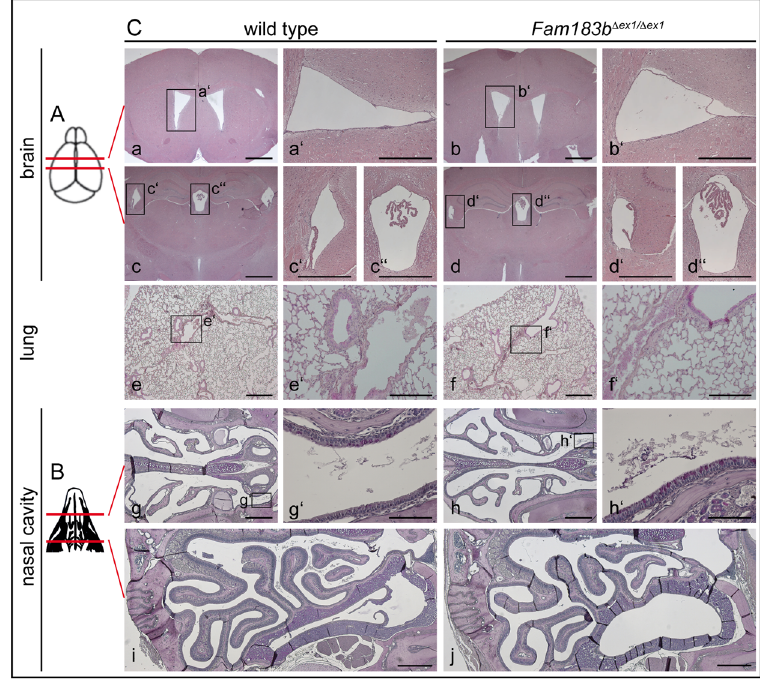
Figure 5. Histological analysis of Fam183b -mutant tissues. ( A ) Schematic drawing showing the planes of sections shown in ( C a–d). ( B ) Scheme depicting planes of sections shown in ( C g–j). ( C a–d) Representative sections of wild type (a,c) and Fam183b Δ ex1 mutant brains (b,d) at the two horizontal levels indicated in ( A ). Boxed areas indicate the regions shown at higher magnification in a’,b’,c’,c’’,d’ and d’’. ( C e,f) Representative sections of wild type (e) and Fam183b Δ ex1 mutant (f) lungs. Boxed areas indicate the regions shown at higher magnification in e’,f’. ( C g–j) Representative sections of wild type (g,i) and Fam183b Δ ex1 mutant (h,j) nasal cavities at the two horizontal levels indicated in ( B ). Boxed areas indicate the regions shown at higher magnification in g’ and h’. Scale bars: a,b,c,d: 1 mm; a’, b’,c’,c’’,d’,d’’: 500 μ m; e,f: 500 μ m; e’,f’: 200 μ m; g–j: 500 μ m; g’,h’: 100 μ